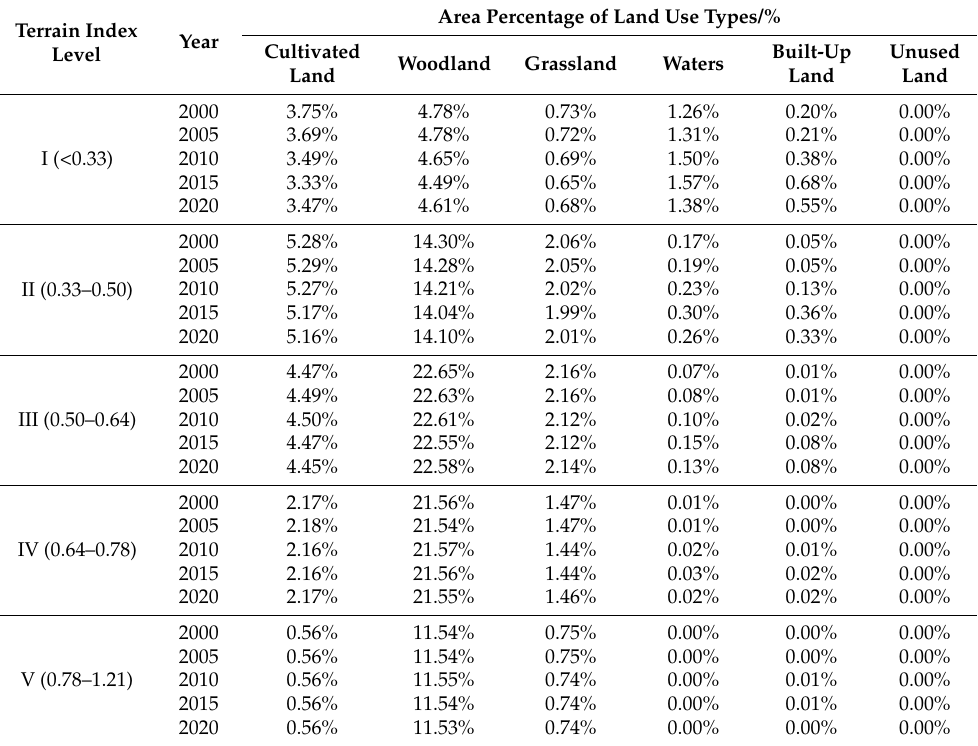
Table 6. Changes in area percentage represented by land use types for each terrain index level in Shiyan from 2000 to